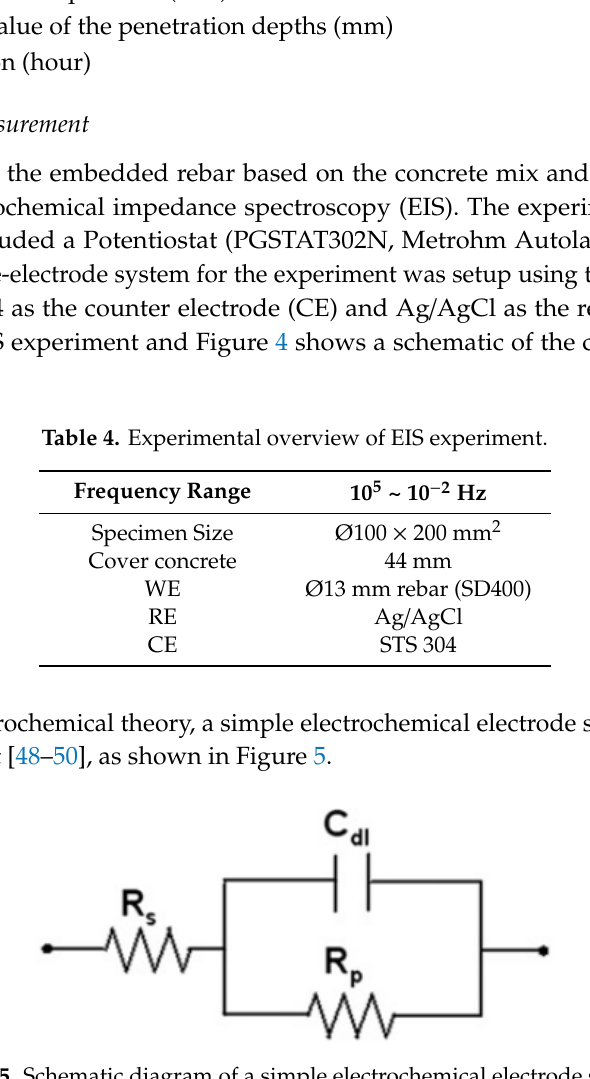
Figure 5. Schematic diagram of a simple electrochemical electrode system.